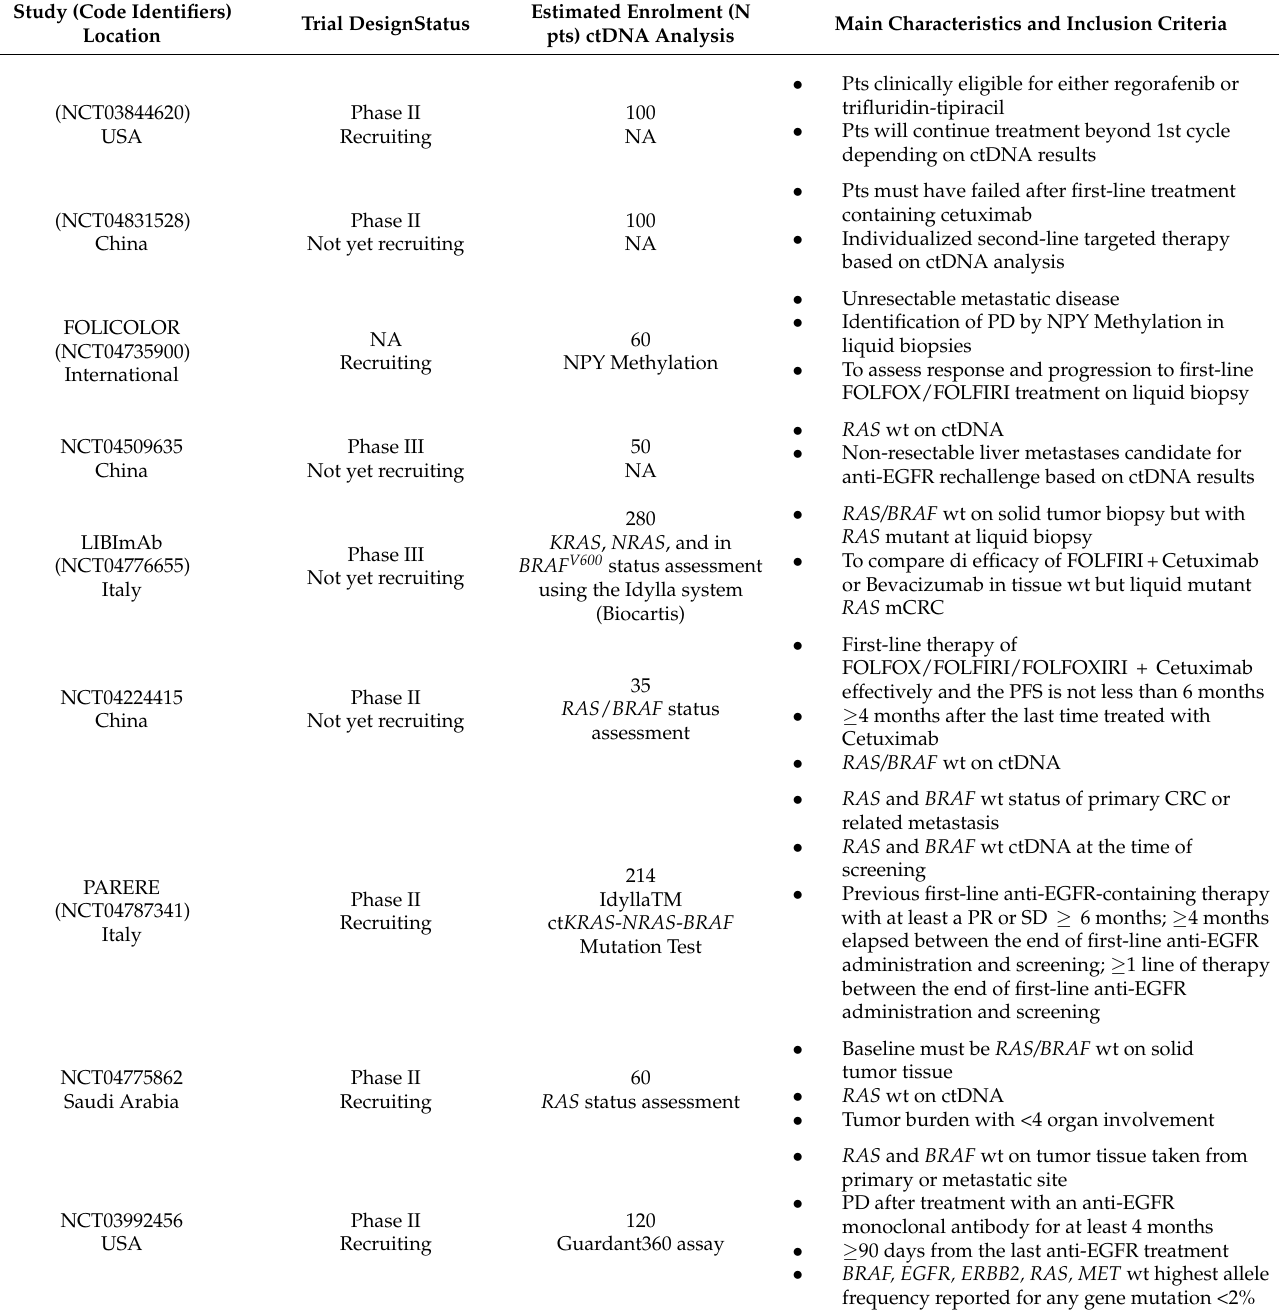
Table 2. Notable clinical trials of ctDNA in patients with metastatic colorectal